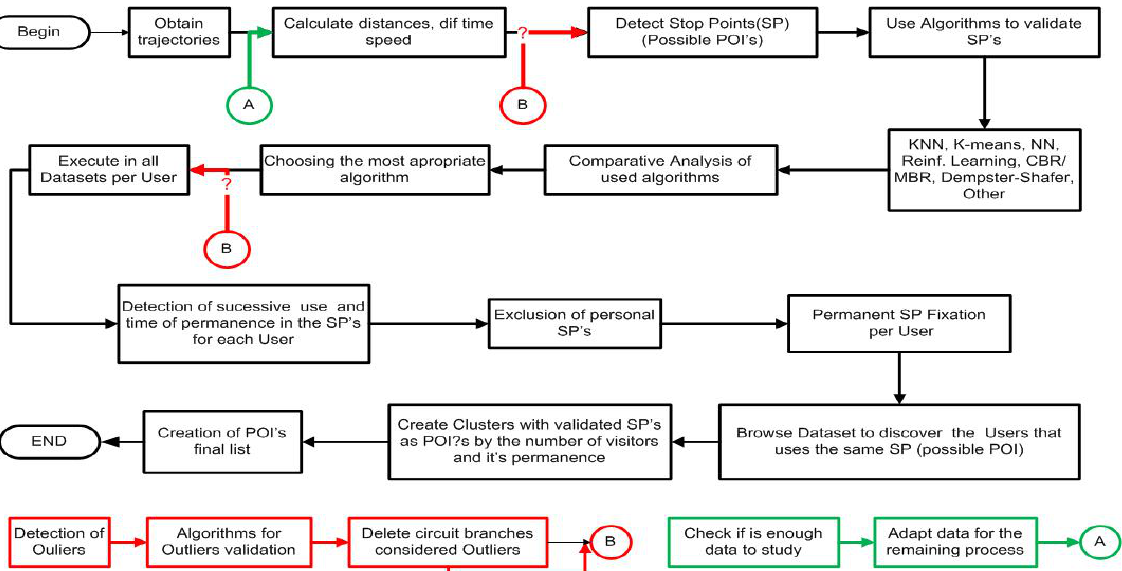
Figure 1. Functional blocks of a framework for continuous detection of PoIs in a Smart City, assuming data obtained in close to real time from MCS